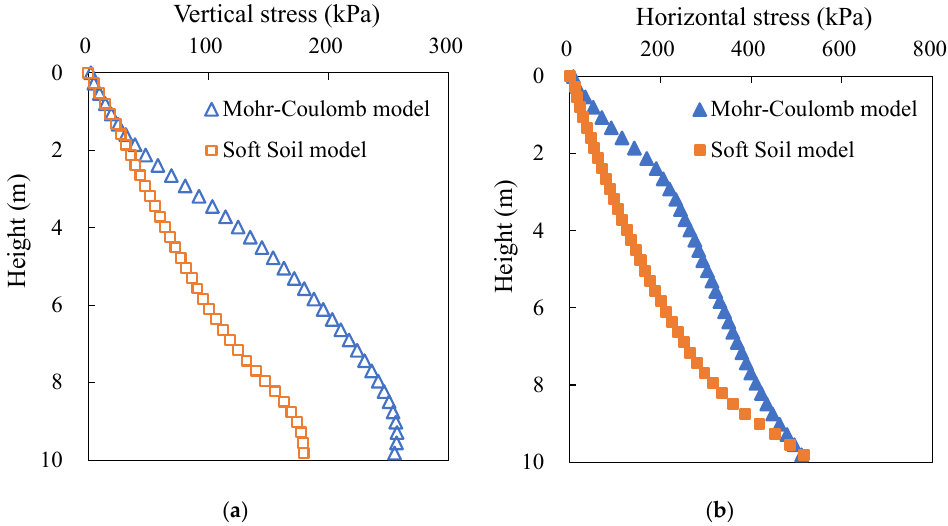
Figure 14. Variations of the ( a ) vertical and ( b ) horizontal stresses along the VCL of overlying backfill after excavating the underlying stope at a mine depth of 200